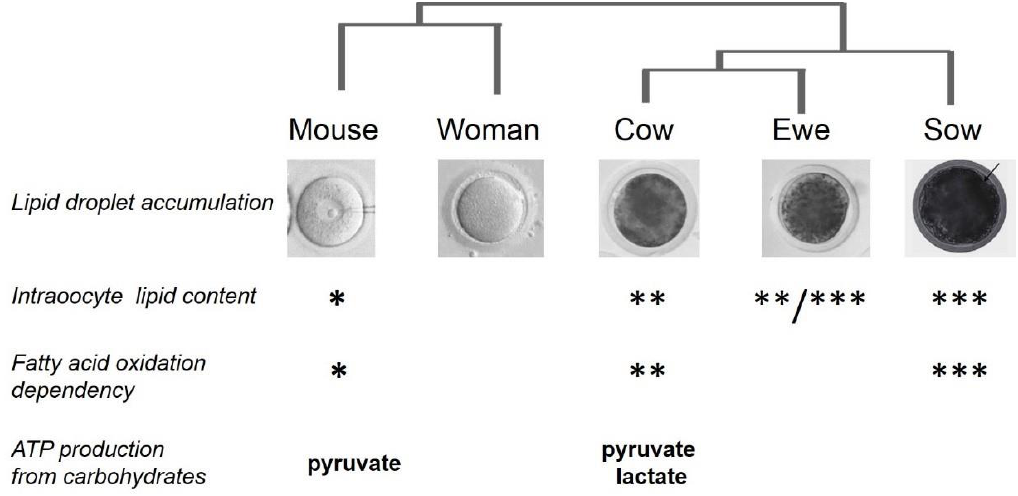
Figure 4. Importance of carbohydrate and lipid metabolism during oocyte maturation in five mammalian species. Brightfield microscopy pictures show the darkening of the oocyte cytoplasm (from mouse to sow) reflecting the increasing content in lipid droplets, coherent with the fatty acid amount from triglycerides and phospholipids [228,229], and the dependency on fatty acid oxidation, as assessed by the impact of pharmacological inhibition of carnitine palmitoyltransferase 1 [201,203]. The number of asterisks correlates with the amount/importance of these parameters. Carbohydrate metabolism is activated from distinct substrates.